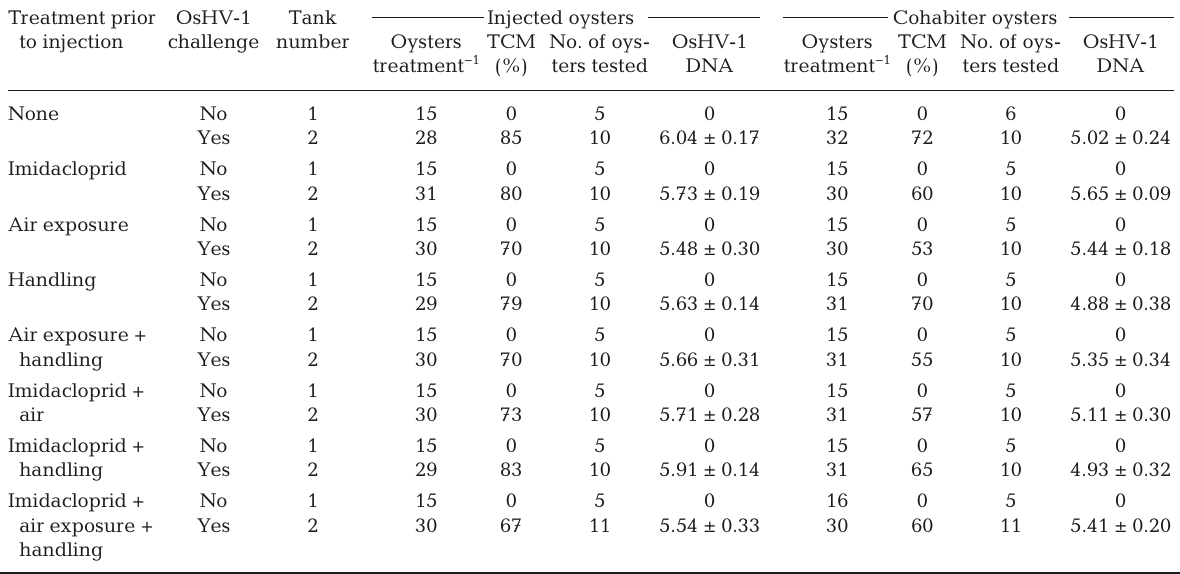
Table 1. Mortality and level of OsHV-1 DNA in Pacific oyster tissues in the different treatments. Data are the mean total cumulative mortality (TCM) for duplicate tanks for each treatmentfor oysters challenged by injection and cohabitation; quantity of log 10 (OsHV-1